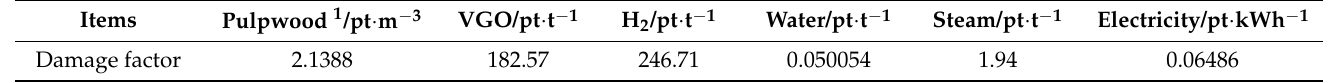
Table 4. Damage factors of input streams: raw materials and utilities.